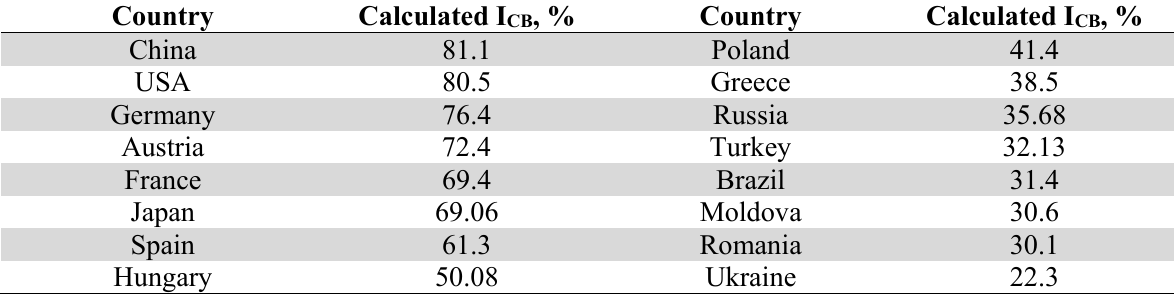
Calculated Country Brand Index (as of 2017) Country Calculated І CB , % Country Calculated І CB ,